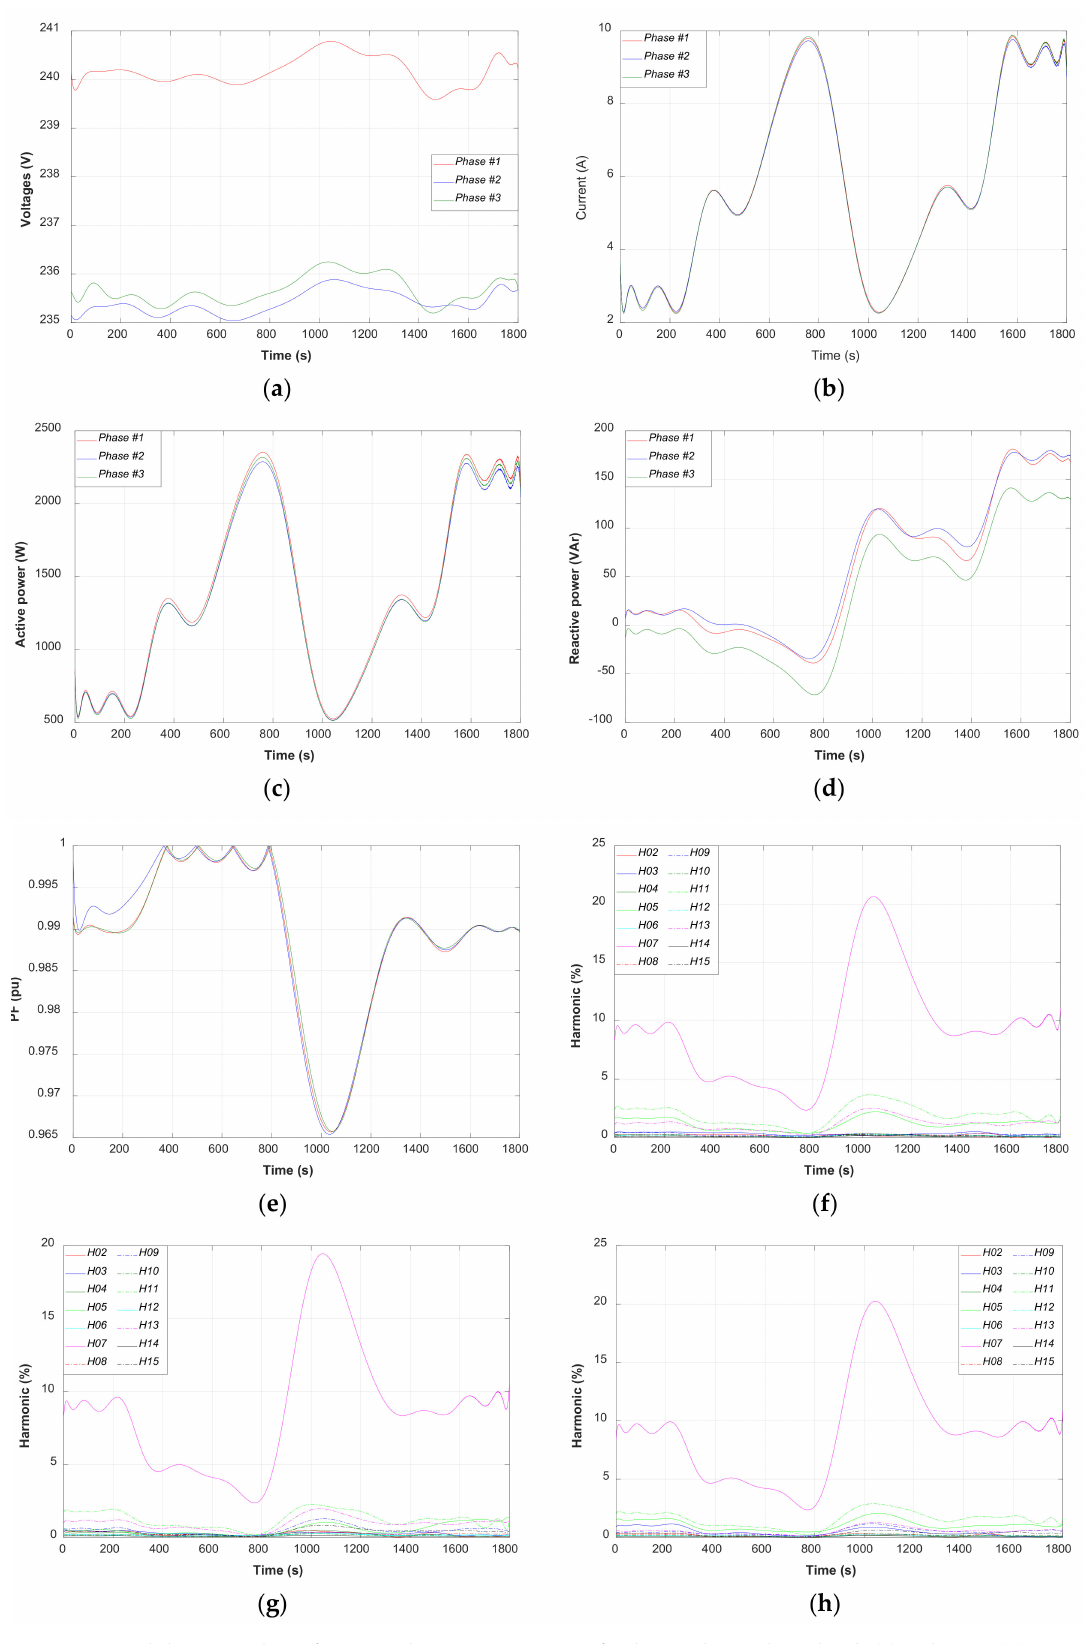
Figure 24. Measured data per phase for a synchronous generator feeding a three-phase load: ( a ) voltages; ( b ) currents; ( c ) active powers; ( d ) reactive powers; ( e ) power factor; ( f ) Phase #1 current harmonics; ( g ) Phase #2 current harmonics; and ( h ) Phase #3 current